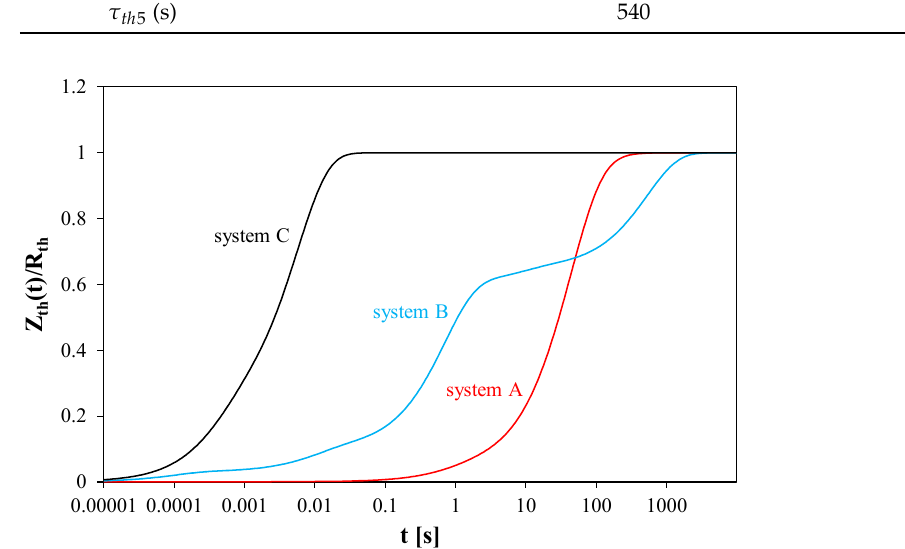
Figure 4. Transient thermal impedance waveforms normalized to thermal resistance for the consid- ered cooling systems.